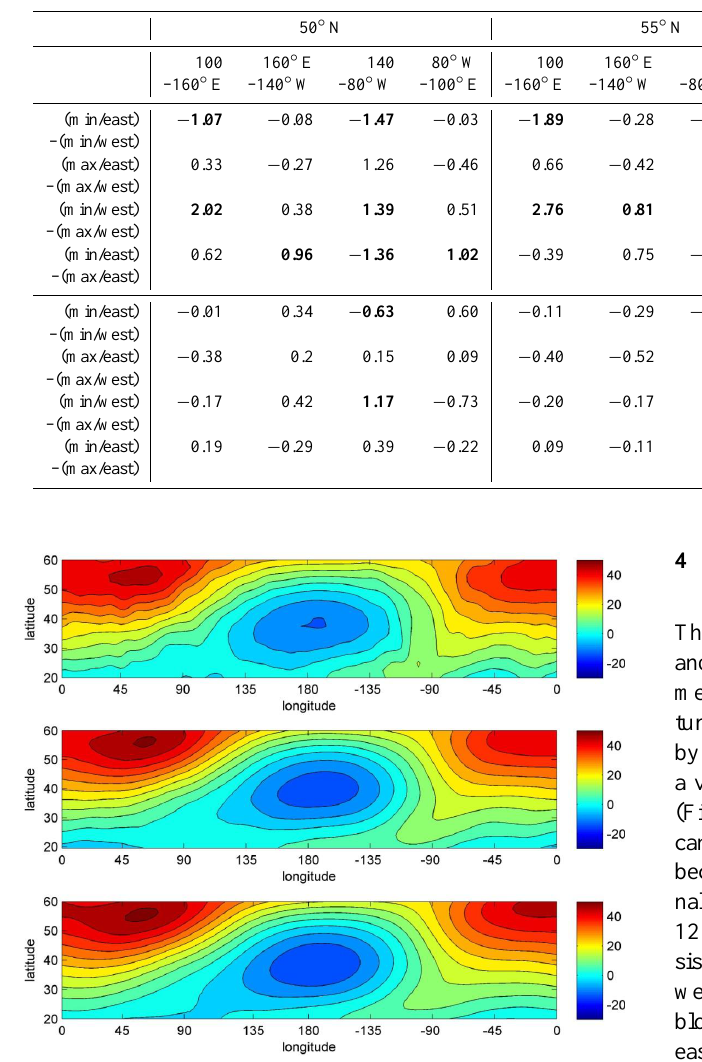
Figure 6. Plot of average zonal wind speed (ms − 1 ) component for January at 20–60 ◦ N, 180 ◦ E–180 ◦ W and 10hPa. Top panel: NCEP/NCAR (1958–2012); middle: ERA-Interim (1979–2012); bottom: MERRA (1979–2012). Positive values (eastward wind): red; negative values (westward wind): blue.